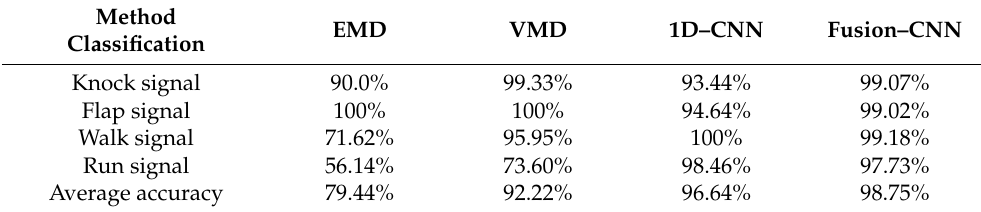
Table 4. Comparison of experimental results of three classification